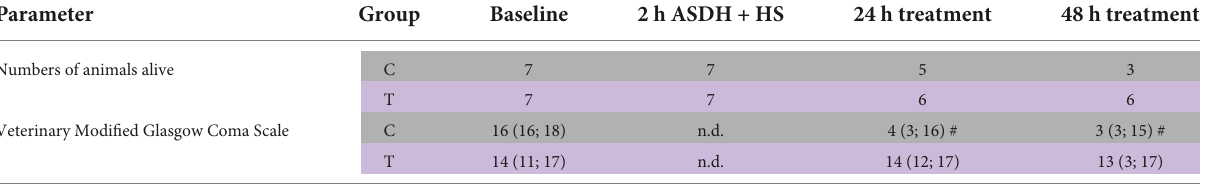
TABLE 2 Assessment of the veterinary Modified Glasgow Coma